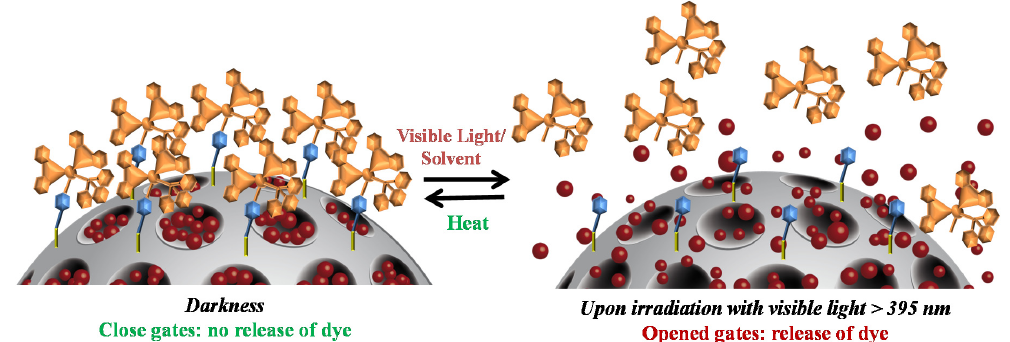
Figure 3. Scheme of the reversible light-triggered opening mechanism from loaded mesoporous silica nanoparticles surface functionalized with one of the proposed ruthenium-based complex systems (MSN2-RC2). Under visible light irradiation ( > 395 nm), the photochemical cleavage of the ligands leads to opened gates with a subsequent release of the dye in aqueous suspension. If heat is applied (at 80 °C), the system closes reversibly and no release is observed.